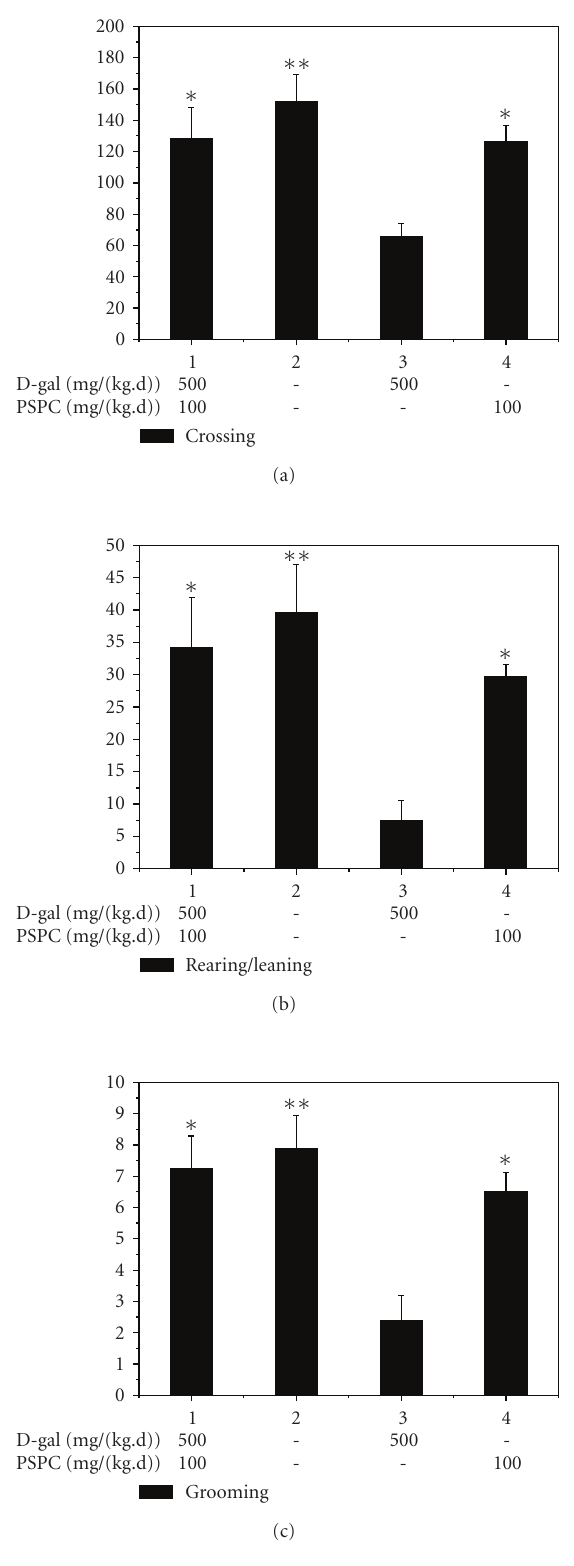
Figure 1: E ff ects of PSPC on open-field behaviors of mice as measured by (a) the number of grid crossing, (b) rearing and leaning, and (c) grooming. All values are expressed as means ± SEM ( n = 8) . ∗ P < . 05, ∗∗ P < . 01, ∗∗∗ P < . 001 versus D-gal model. Scale bars: 100 μ M.